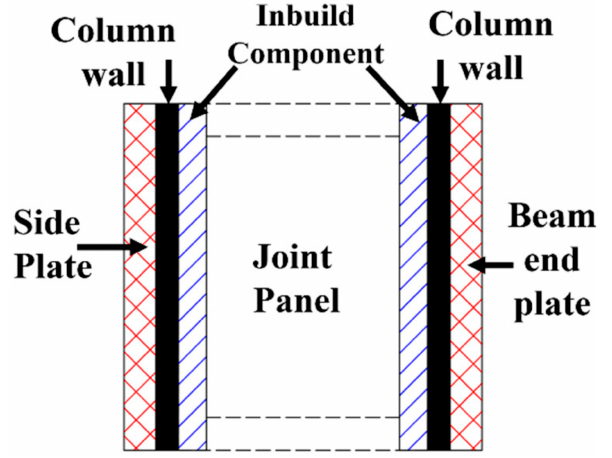
Figure 33. The reinforcement of inbuild component to joint